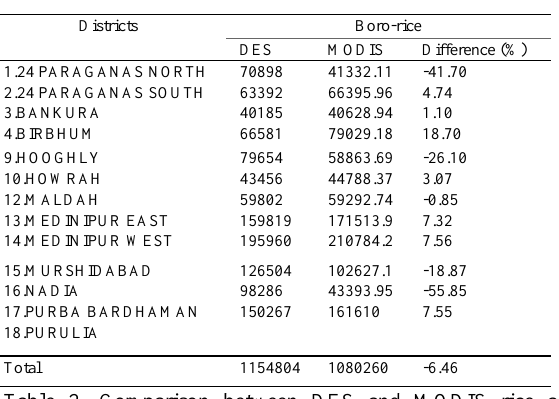
Table 1. Comparison between DES and MODIS rice area